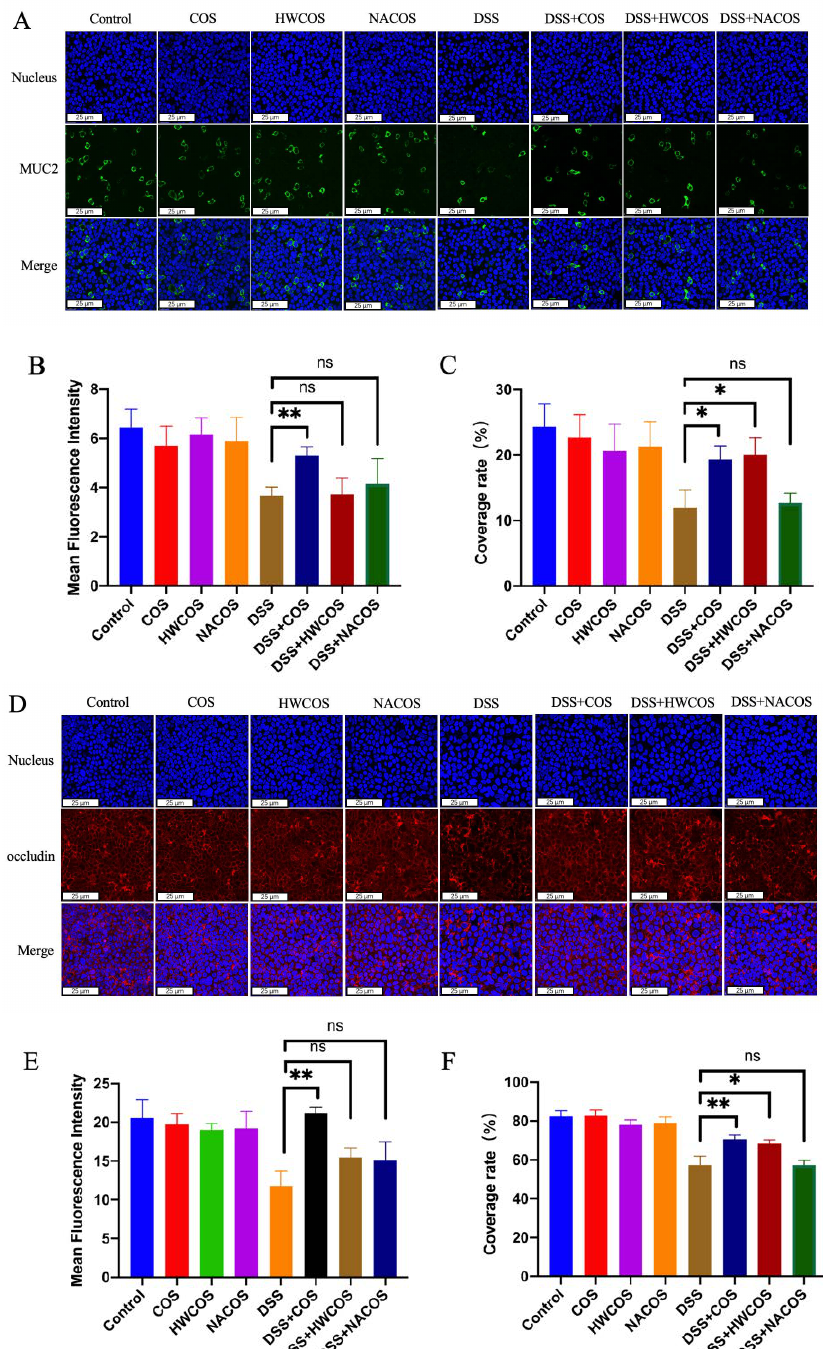
Figure 2. Effect of COS, HWCOS (high-molecular-weight chitosan oligosaccharide), and NACOS (chitin oligosaccharide) on the expression of MUC2 and occludin in HT-29 and Caco-2 cells. ( A ) Im- munofluorescence views of MUC2 (green) secreted by HT-29 cells in the control, COS, HWCOS, NACOS, DSS, DSS + COS, DSS + HWCOS, and DSS + NACOS groups; ( D ) immunofluorescence views of occludin (red) secreted by Caco-2 cells in the control, COS, HWCOS, NACOS, DSS, DSS + COS, DSS + HWCOS, and DSS + NACOS groups; computerized quantification of the mean fluorescence intensity and the coverage rate of MUC2 ( B , C ) or occludin ( E , F ) was performed. The average value of randomly taken images were calculated ( n = 9; * p < 0.05, ** p < 0.01). Error bar represents the standard deviation. Images represent the typical situation of three independent experiments. Scale bars, 25 µ